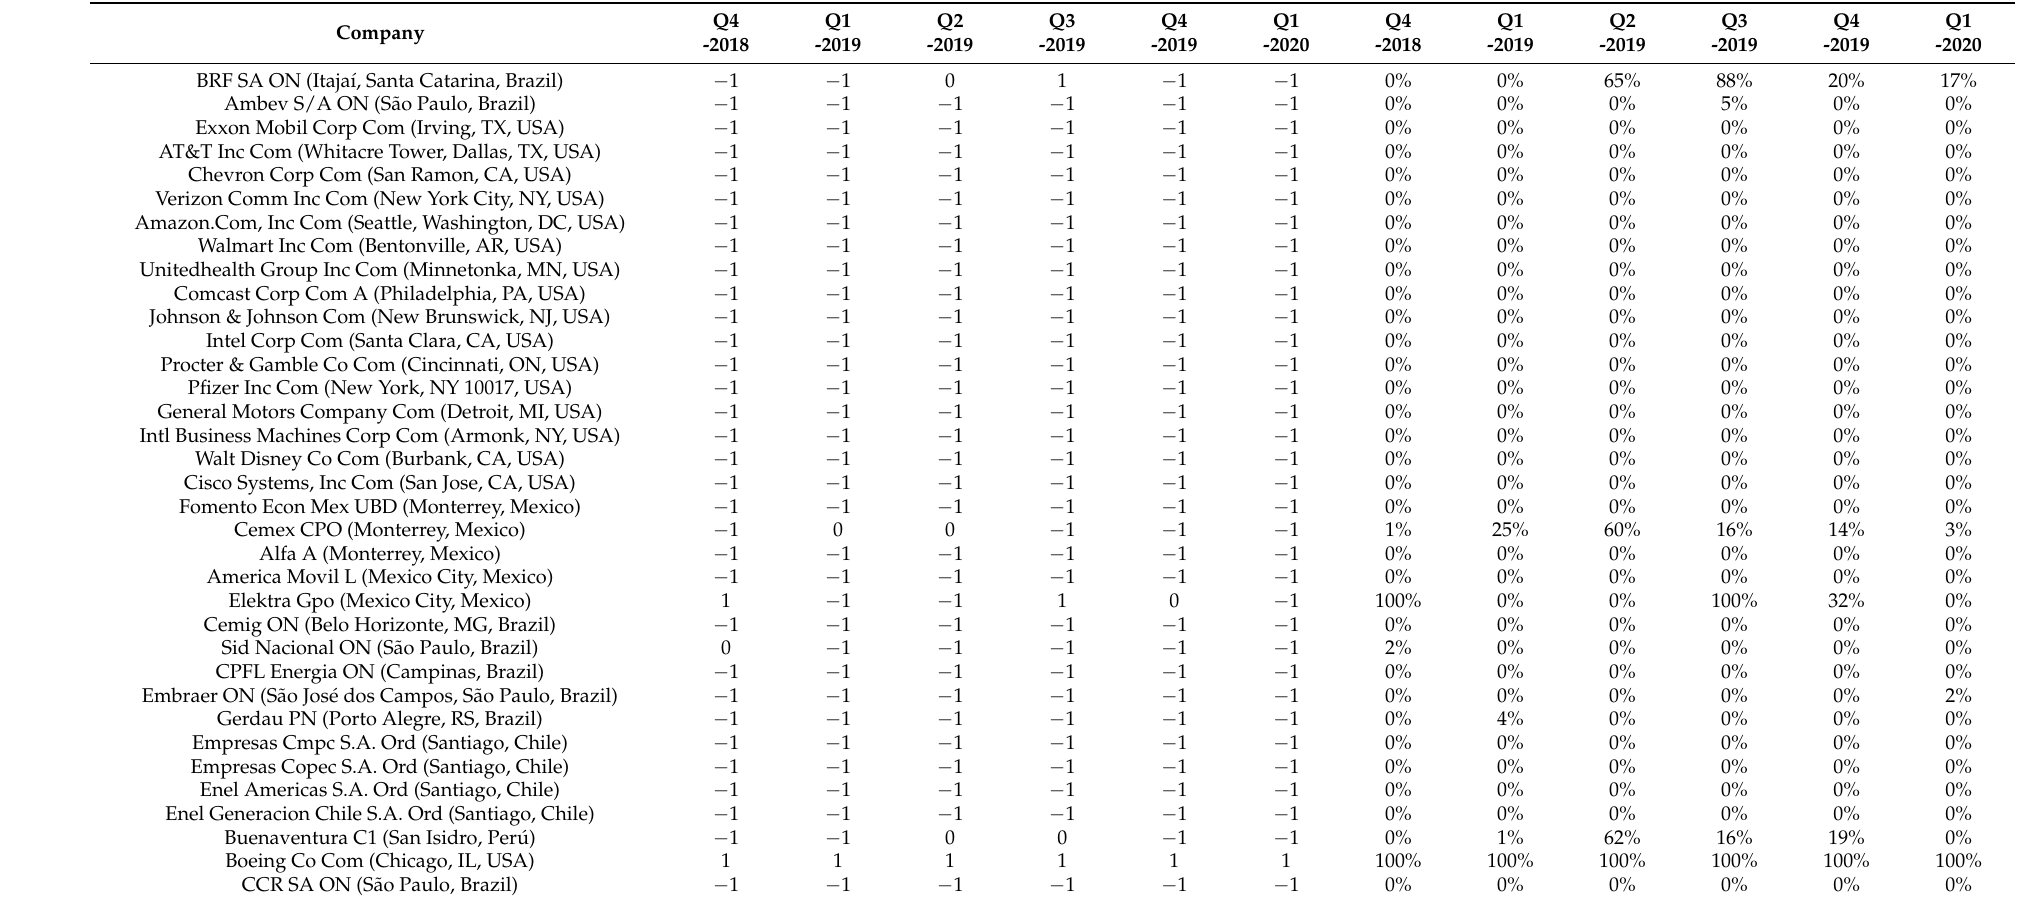
Table 3. Membership of companies by default